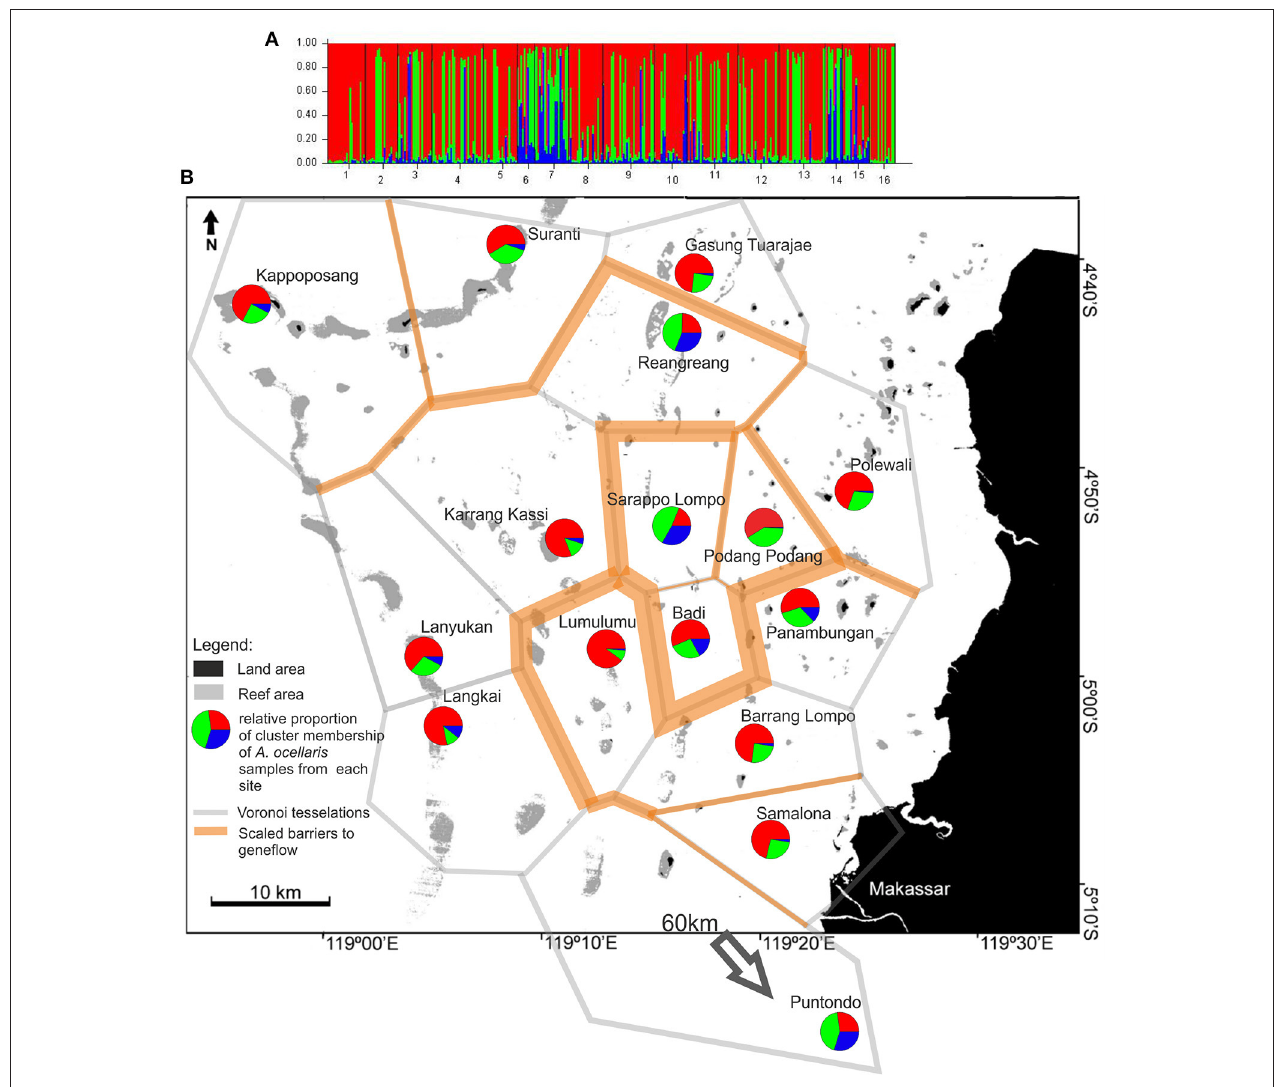
FIGURE 6 | (A) of the figure shows the frequency diagram generated by STRUCTURE (ver. 2.2., Pritchard et al., 2000) as part of the analysis output showing the proportional cluster membership of Polycarpa aurata individuals at sites. (B) Shows the summarized results of the BARRIER analysis (Manni et al., 2004) based on two datasets (control region and microsatellites, P. aurata ) and a projection of the STRUCTURE analysis. For BARRIER, the 10 strongest/most important barriers to gene flow are shown. Red lines indicate barriers detected in both data sets, while orange lines indicate barriers detected in only one dataset. The polygon structures (gray lines/grit) are Voronoï-Tesselations (Voronoï, 1908) as implemented in the software BARRIER (Manni et al., 2004). The pie charts depict the relative proportion of membership of individuals from each site in the three genotype clusters as generated by STRUCTURE (ver. 2.2., Pritchard et al., 2000). The analysis was run for all k from 1 to 10, with the highest probability of correctly dividing the data at k = 3 groups (Supplementary Material 3, Table 1 ). The analysis used the LOCPRIOR model on 332 individuals, from 16 sites, using data from 5 microsatellite loci. The burn-in period was set to 80,000 and 100,000 replicates were